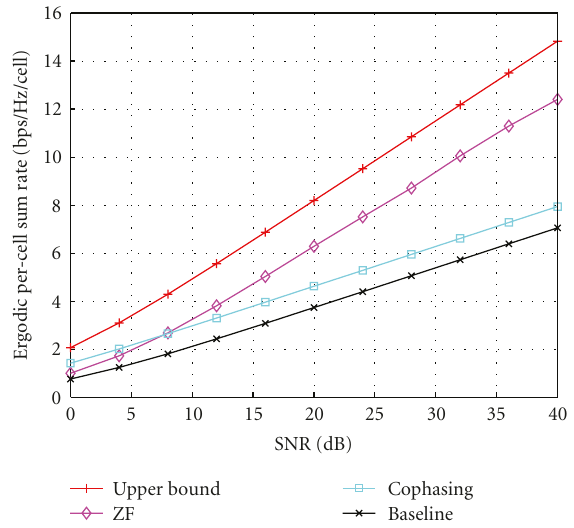
Figure 7: (32,4) single-class network with Rayleigh fading, Monte- Carlo simulation with 20